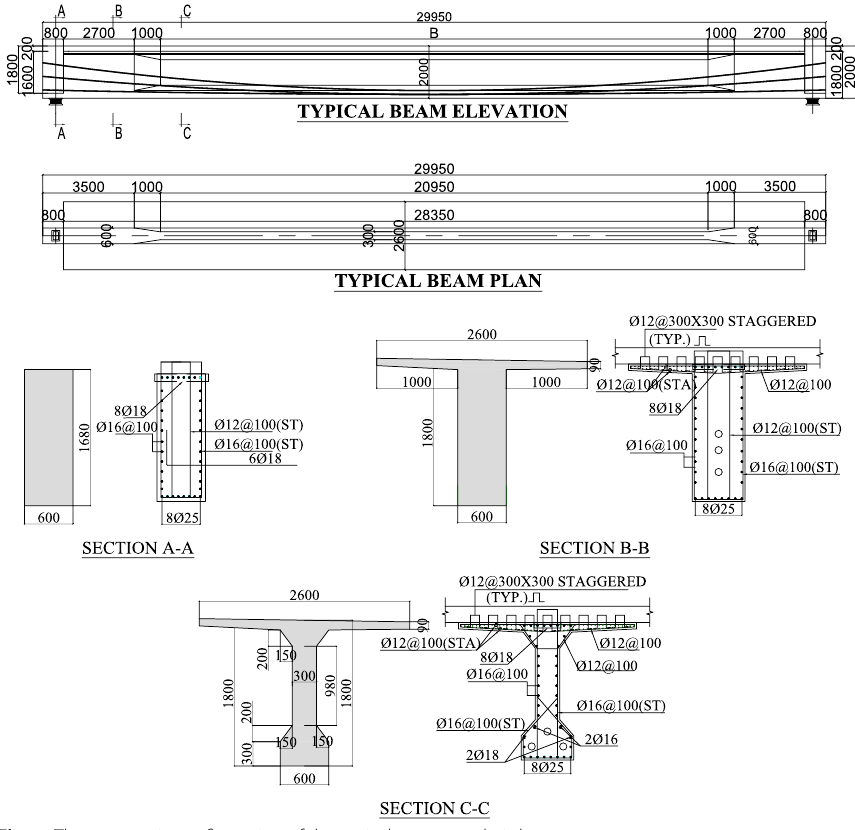
Fig. 5 The geometric configuration of the typical prestressed girder